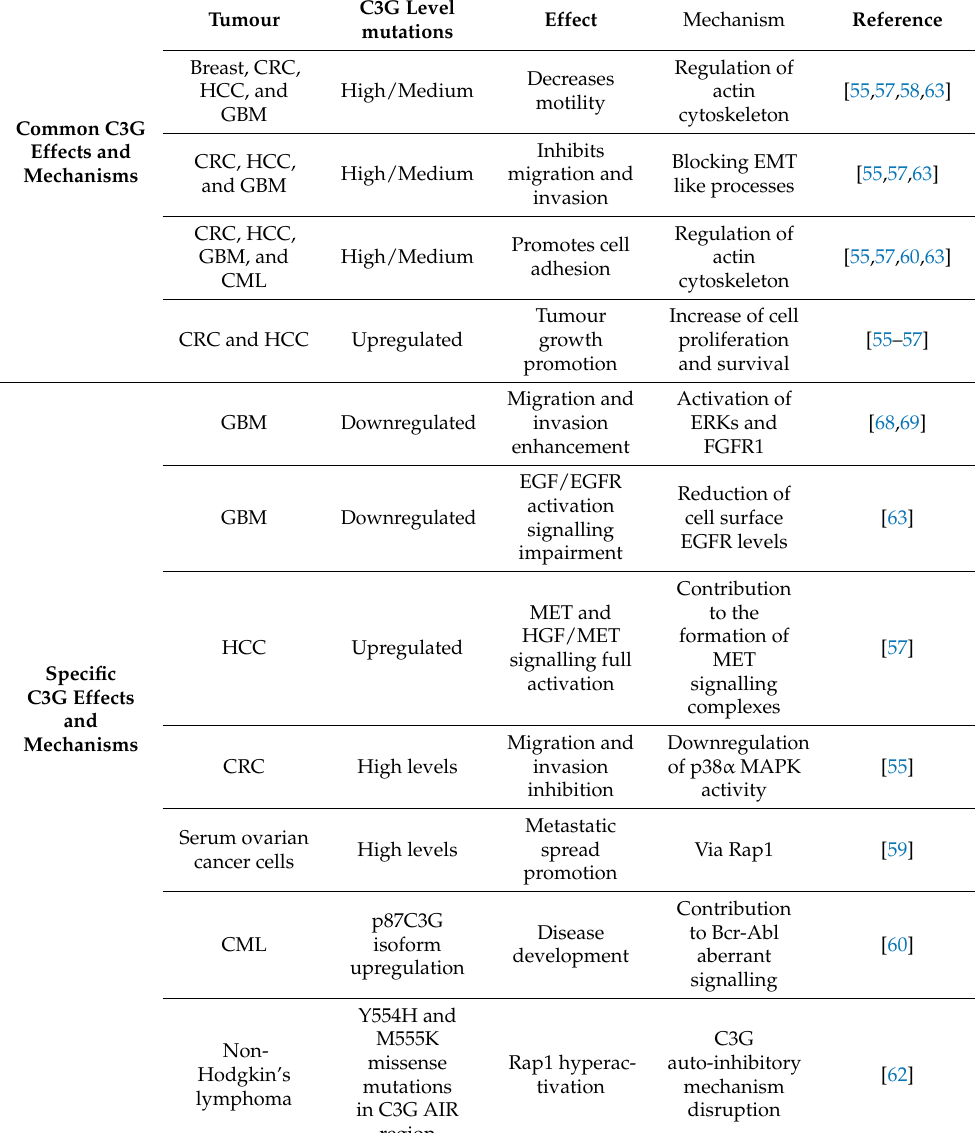
Table 1. Common and specific actions of C3G in different tumours and their